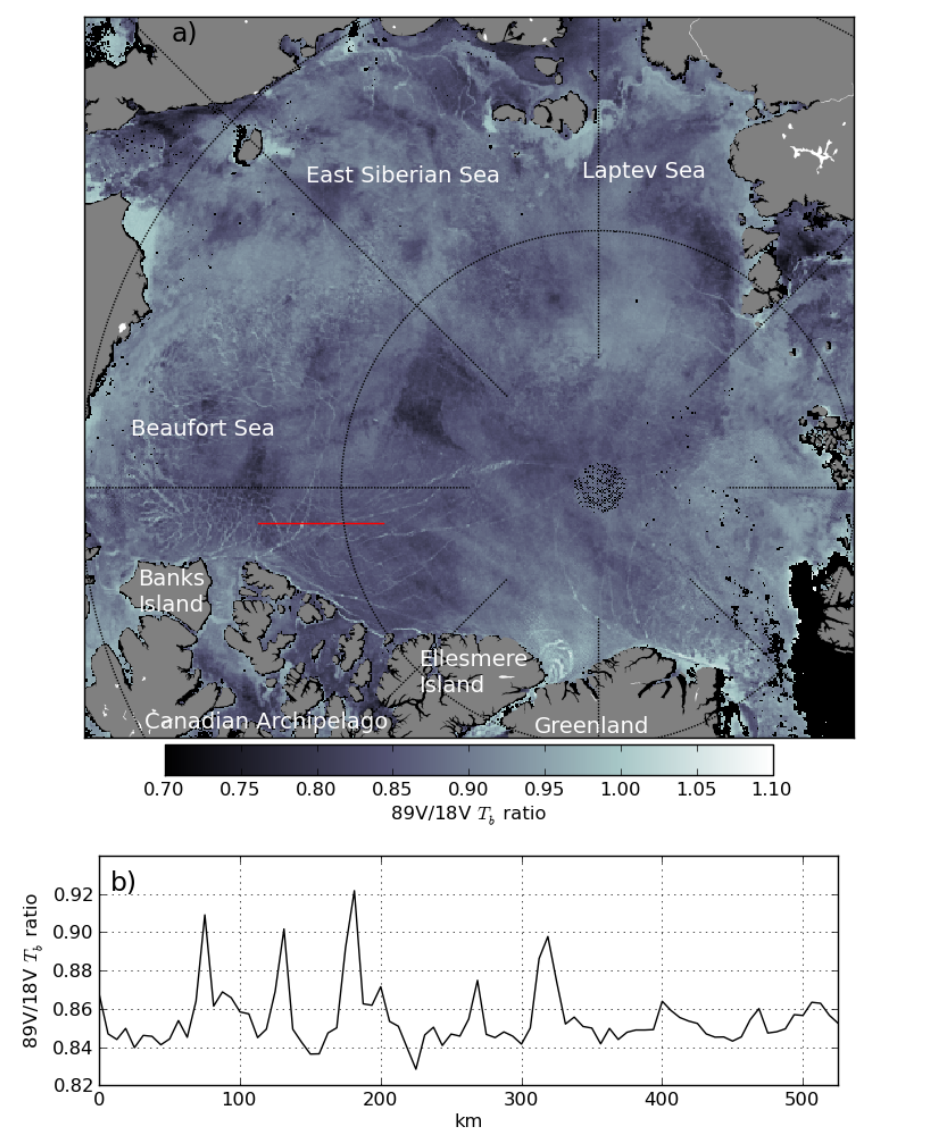
Fig. 2. (a) Brightness temperature ratio r of the 89.0GHz V and 18.7GHz V channels at the 27.02.2007. in the Arctic Ocean. (b) r profile at the red